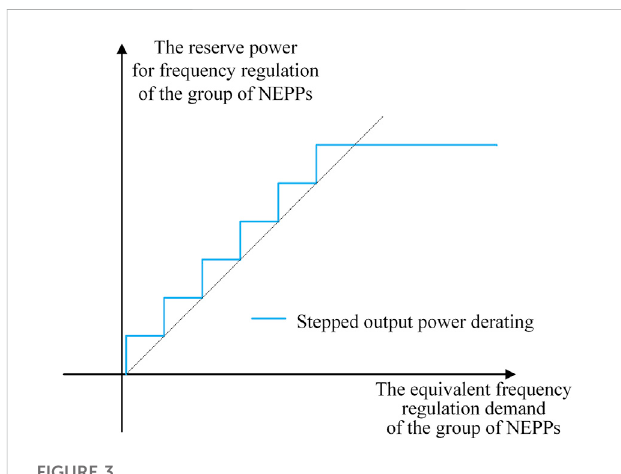
FIGURE 3 The method of stepped reserve power for frequency